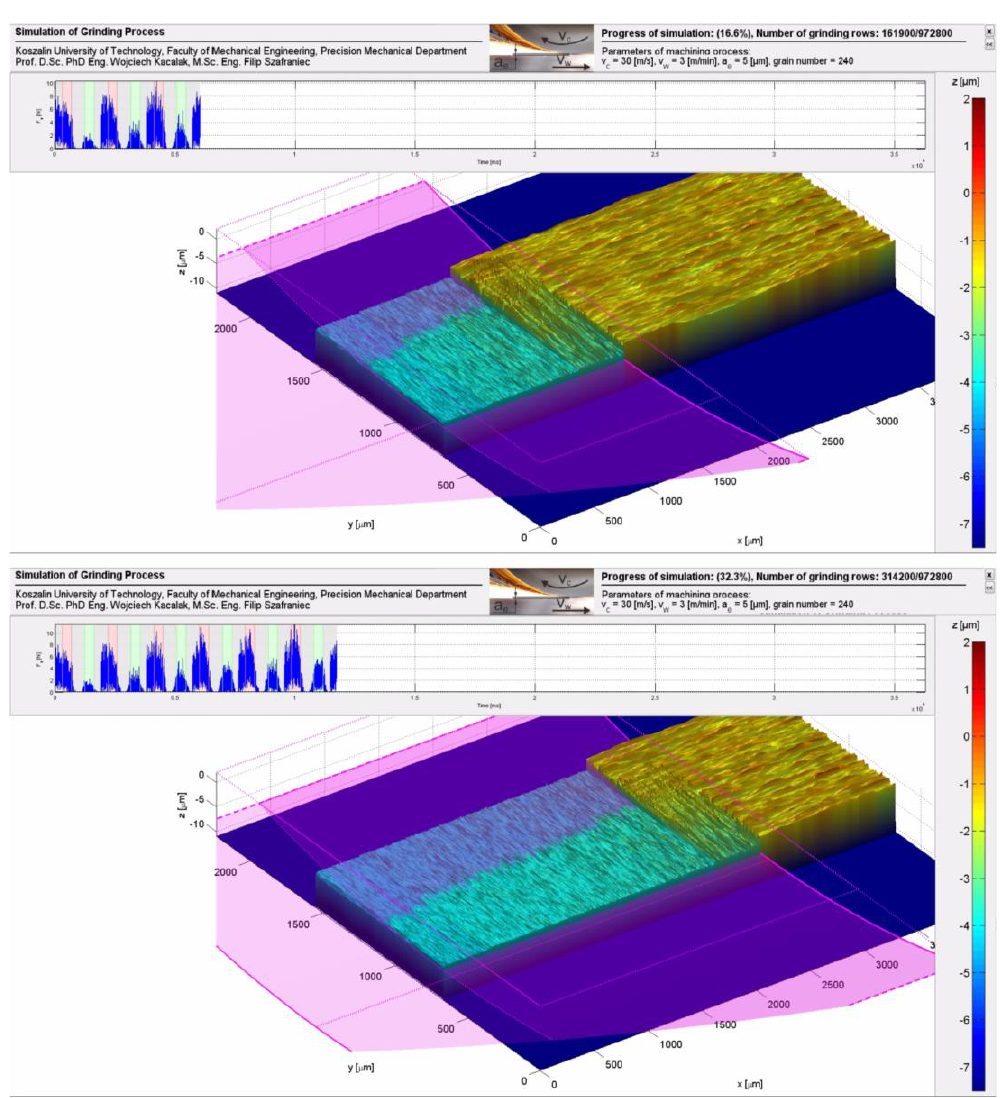
Figure 2. Visualization of selected surface topography states and force variation during the grinding process.